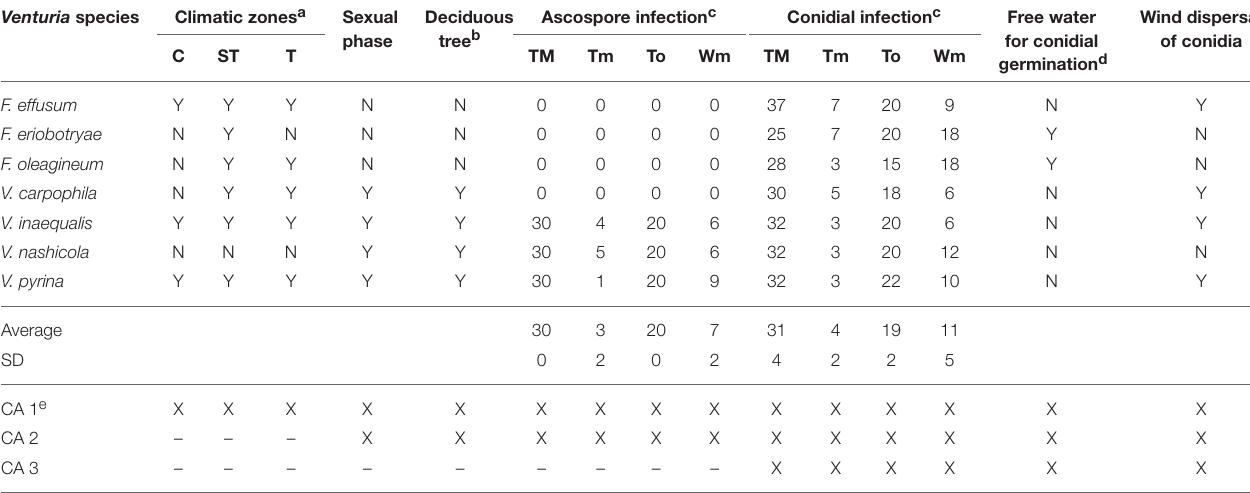
FIGURE 5 | Minimum requirements of temperature and hours of wetness for conidial infection by Venturia spp. The requirements have been modeled by using the equation of Magarey et al. (2005). For each species, the maximum, minimum, and optimal temperatures for infection, and the minimum hours of wetness required are those indicated in Table 4 . TABLE 4 | Epidemiological components of seven Venturia spp. used for three kinds of correspondence analysis (CA1, CA2, and CA3). Venturia